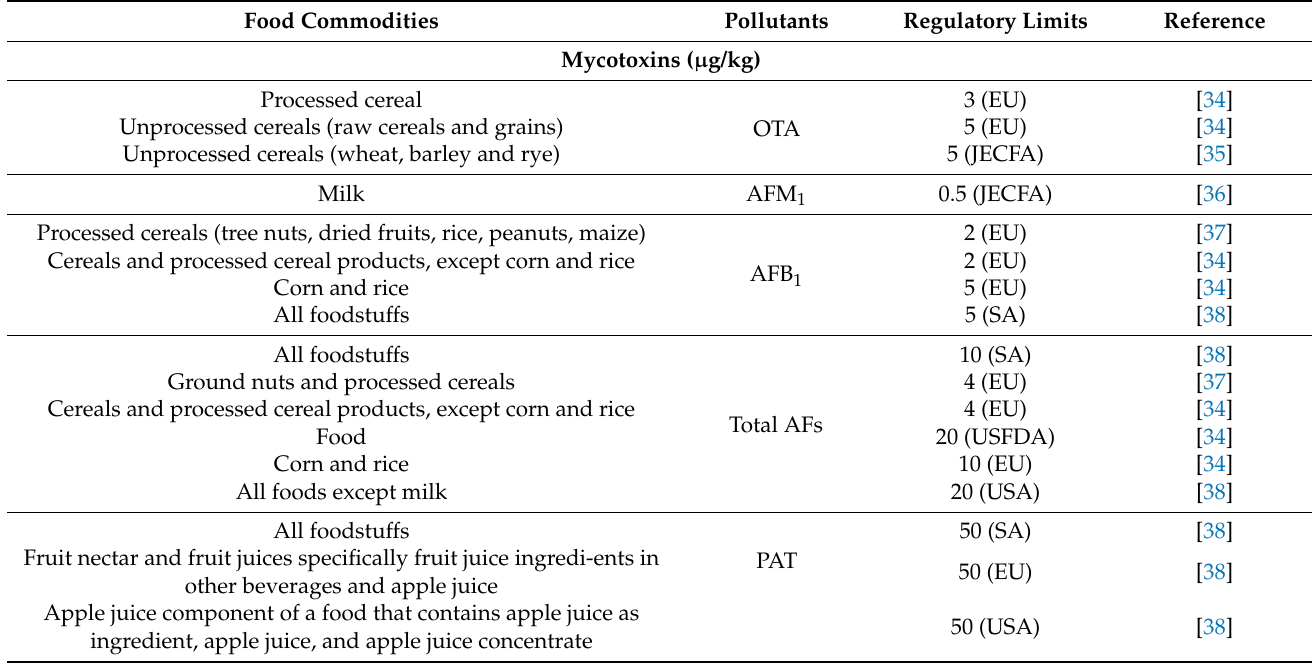
Table 1. The regulatory limits of pollutants in food